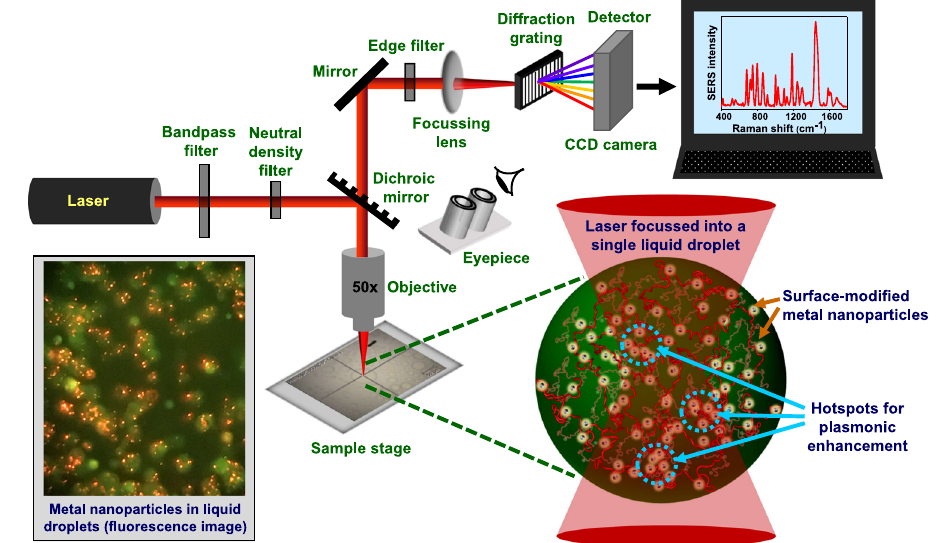
Fig. 1 | A sketch of the optical setup and a schematic of single-droplet normal and surface-enhanced Raman spectroscopy (SERS). A near-infrared (NIR) laser gets focussed within each protein-rich FUS droplet encapsulating surface- functionalizedsilvernanoparticlesthroughanintegratedsystemoflenses,mirrors,